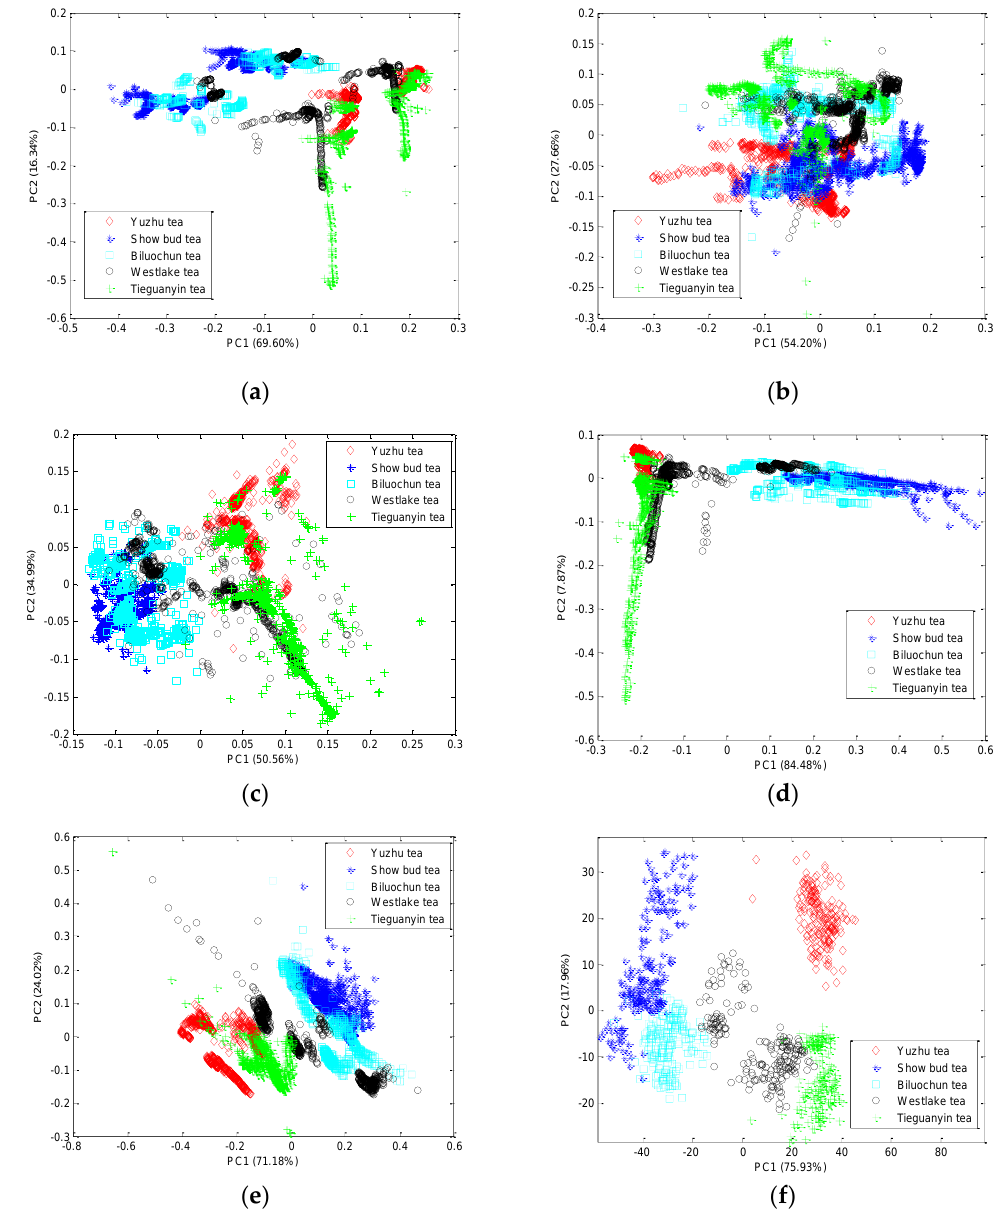
Figure 9. Features show for proposed method and compared methods. ( a ) Two-dimensional (2D) principal component analysis (PCA) features for raw response; ( b ) 2D PCA features for peak-inflection point; ( c ) 2D PCA features for discrete wavelet transform (DWT); ( d ) 2D PCA features for singular value decomposition (SVD); ( e ) 2D PCA features for discrete cosine transform (DCT); ( f ) 2D PCA features for proposed convolutional neural network-based auto features extraction (CNN-AFE) method.